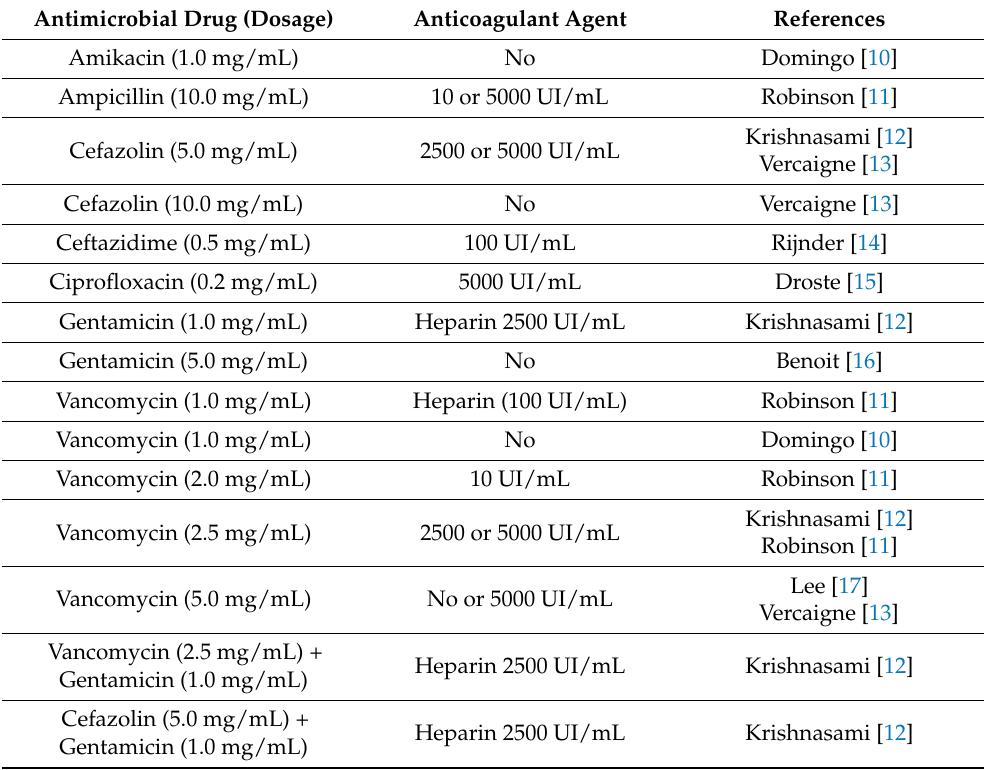
Table 1. Use of different antimicrobial drugs for lock therapy in the neonatal period. Antimicrobial Drug